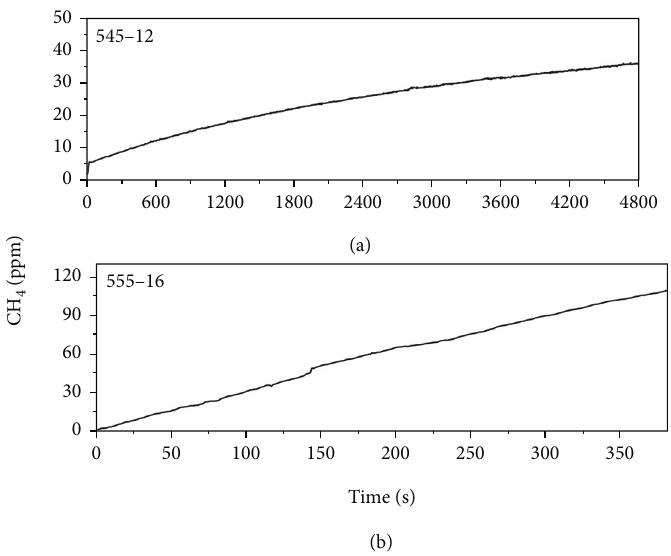
Figure 5: Continuous release: (a) 545-12; (b) 555-16.